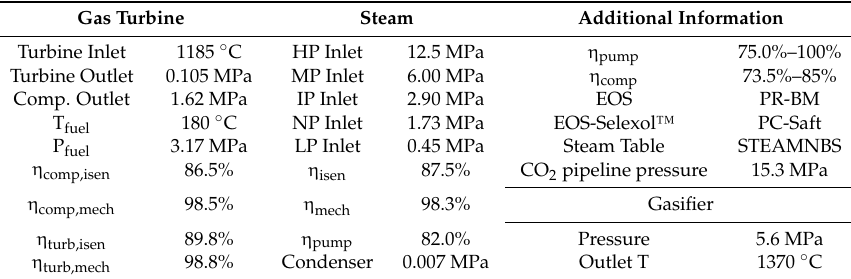
Table 4. List of input parameters that remain constant in all three